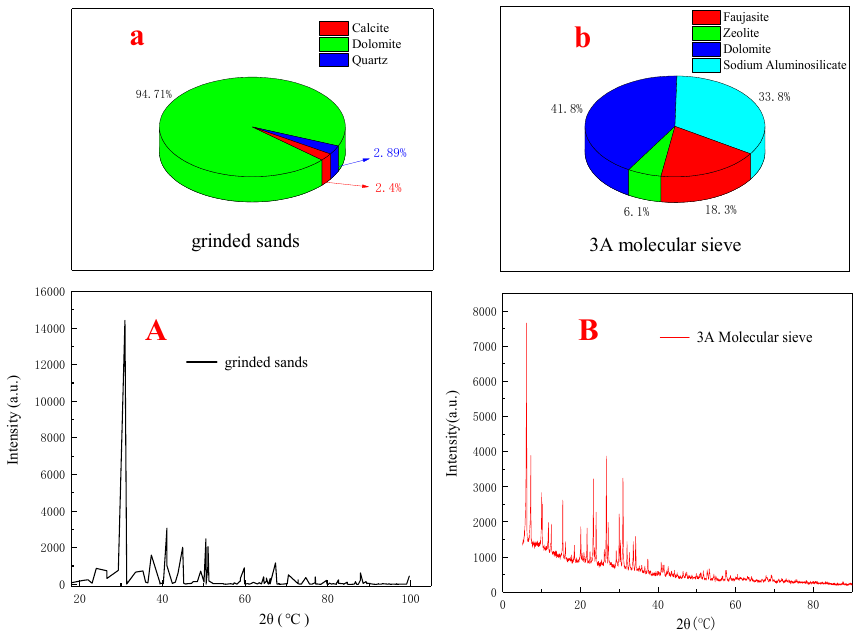
Table 1. Basic parameters of the materials.